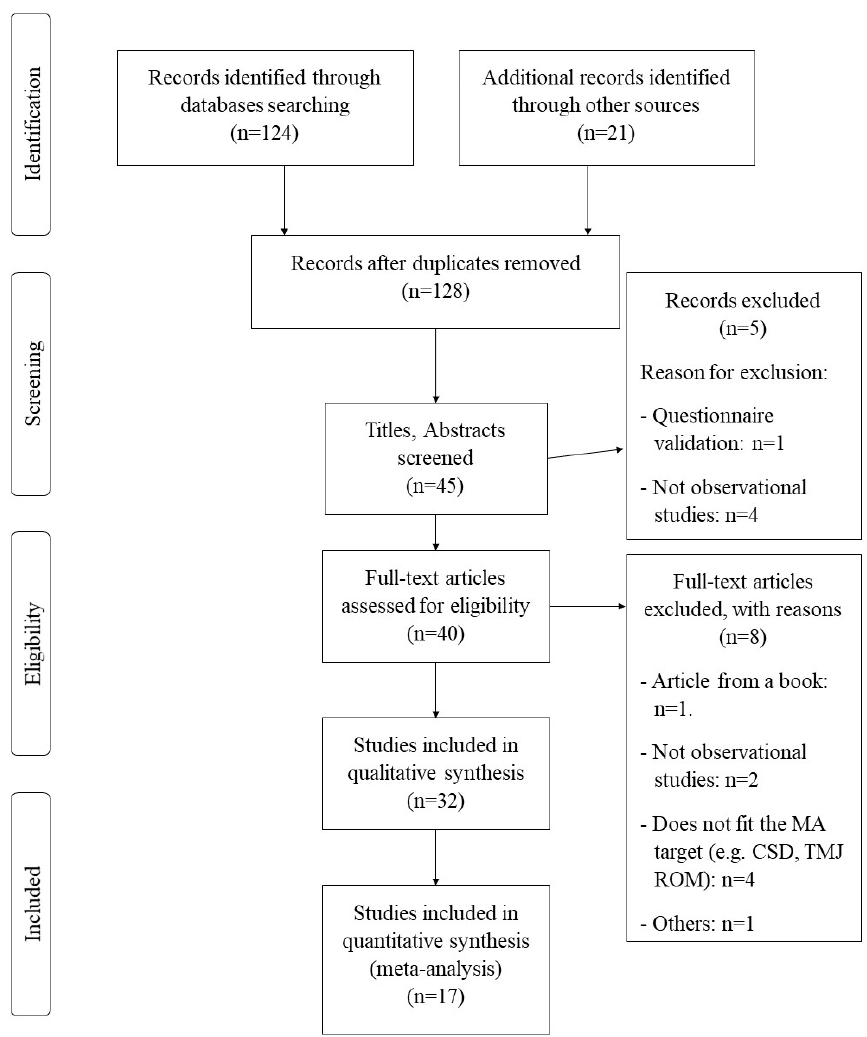
Figure 1. PRISMA flow diagram.